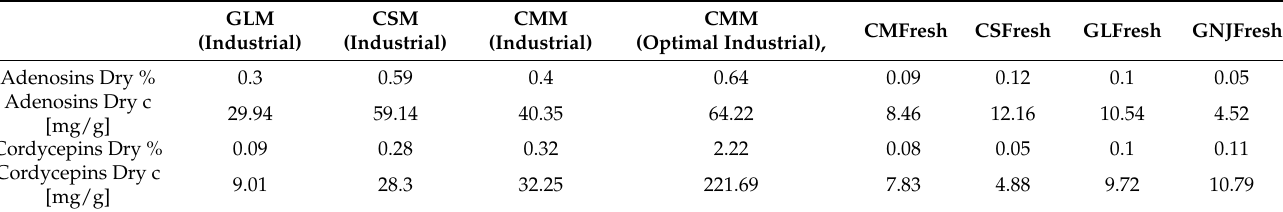
Table 7. HPLC analysis for the determination of cordycepin and adenosine